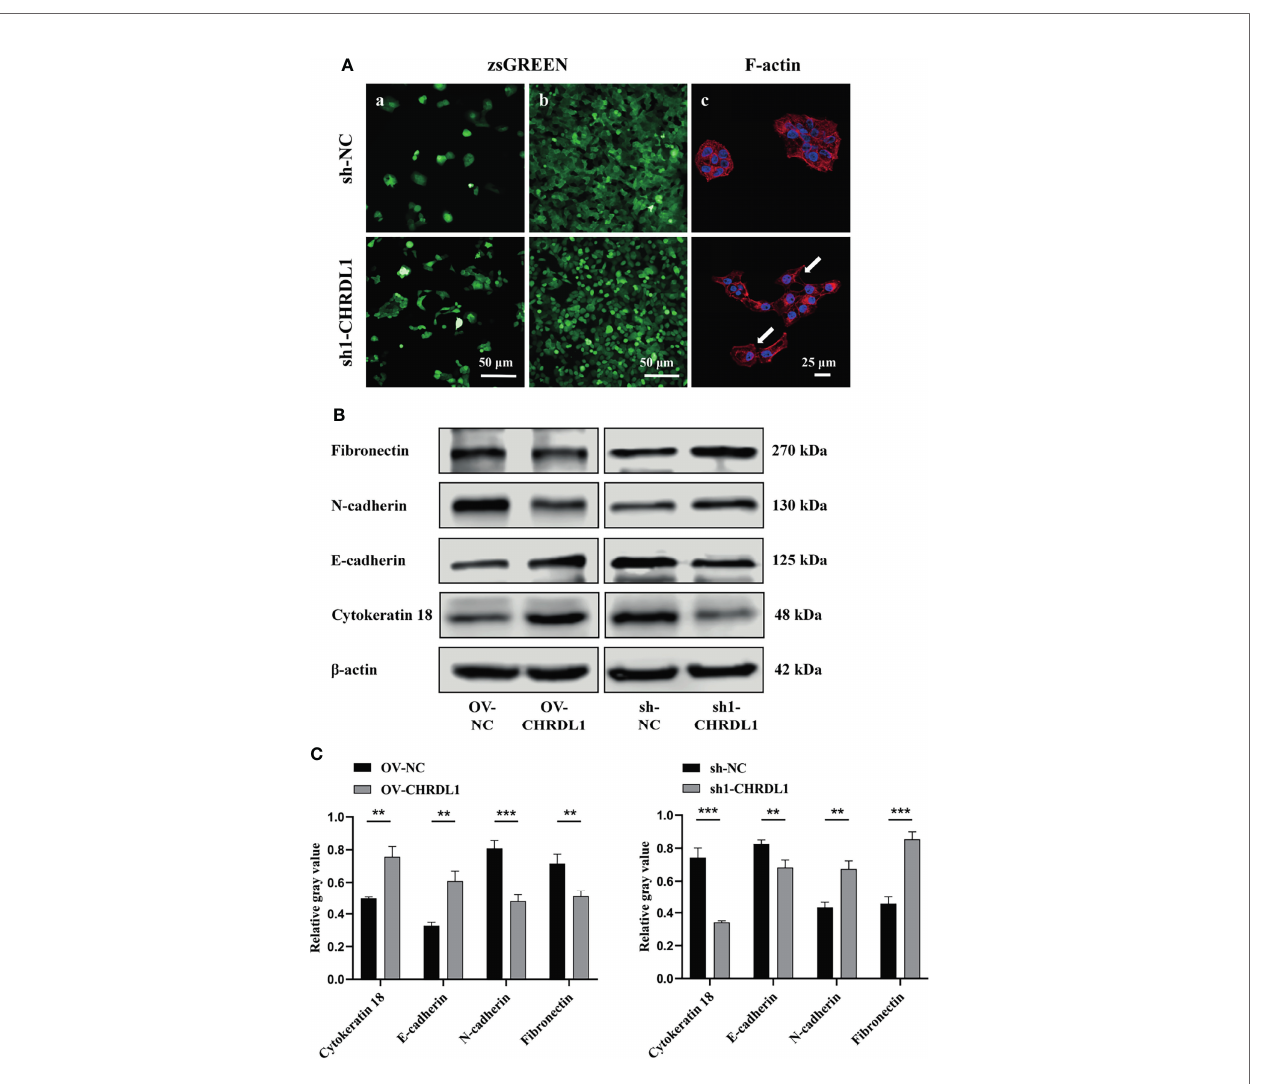
FIGURE 4 | Depletion of CHRDL1 induces the EMT phenotype in CAL27 cells. (A) Representative fl uorescence images of sh-NC/sh1-CHRDL1 CAL27 cells under low (A) and high (b) cell density conditions. (c) Rhodamine-conjugated phalloidin staining of F-actin in sh-NC/sh1-CHRDL1 CAL27 cells, examined using confocal microscopy. The arrows indicate fi lopodia. (B, C) The expression of EMT markers (Fibronectin, N-cadherin, E-cadherin, and Cytokeratin 18) in CAL27 cells after lentivirus transfection was detected by Western blot and quantitatively analyzed. All experiments were performed three times, and one representative experiment is shown. Error bars represent the standard deviation. ** p < 0.01, *** p <